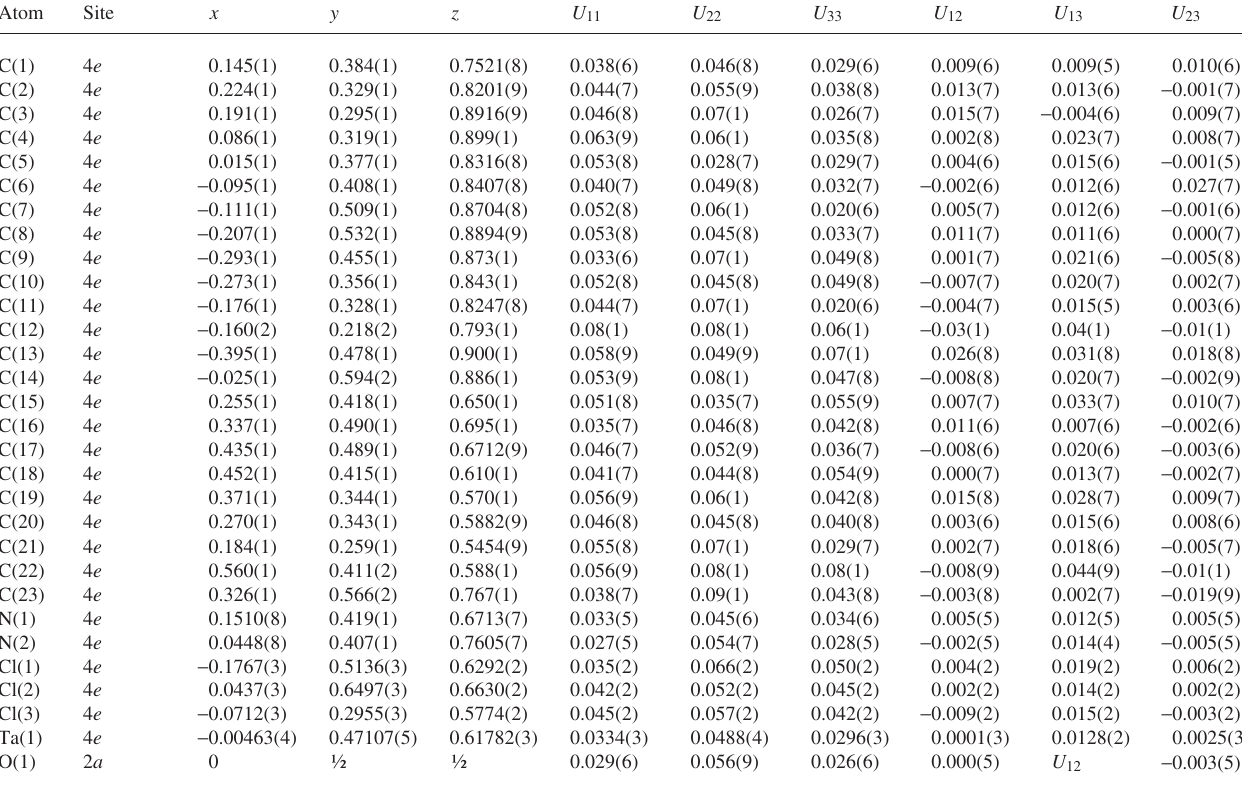
Table 3. Atomic coordinates and displacement parameters (in Å 2 )